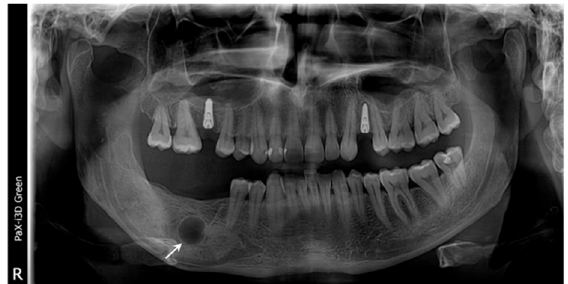
Figure 10. Orthopantomogram shows the second recurrence after one year, a unilocular radiolu- cency lesion, bounded by corticated well-defined margins (arrow), in the same place as the first operated recurrence.